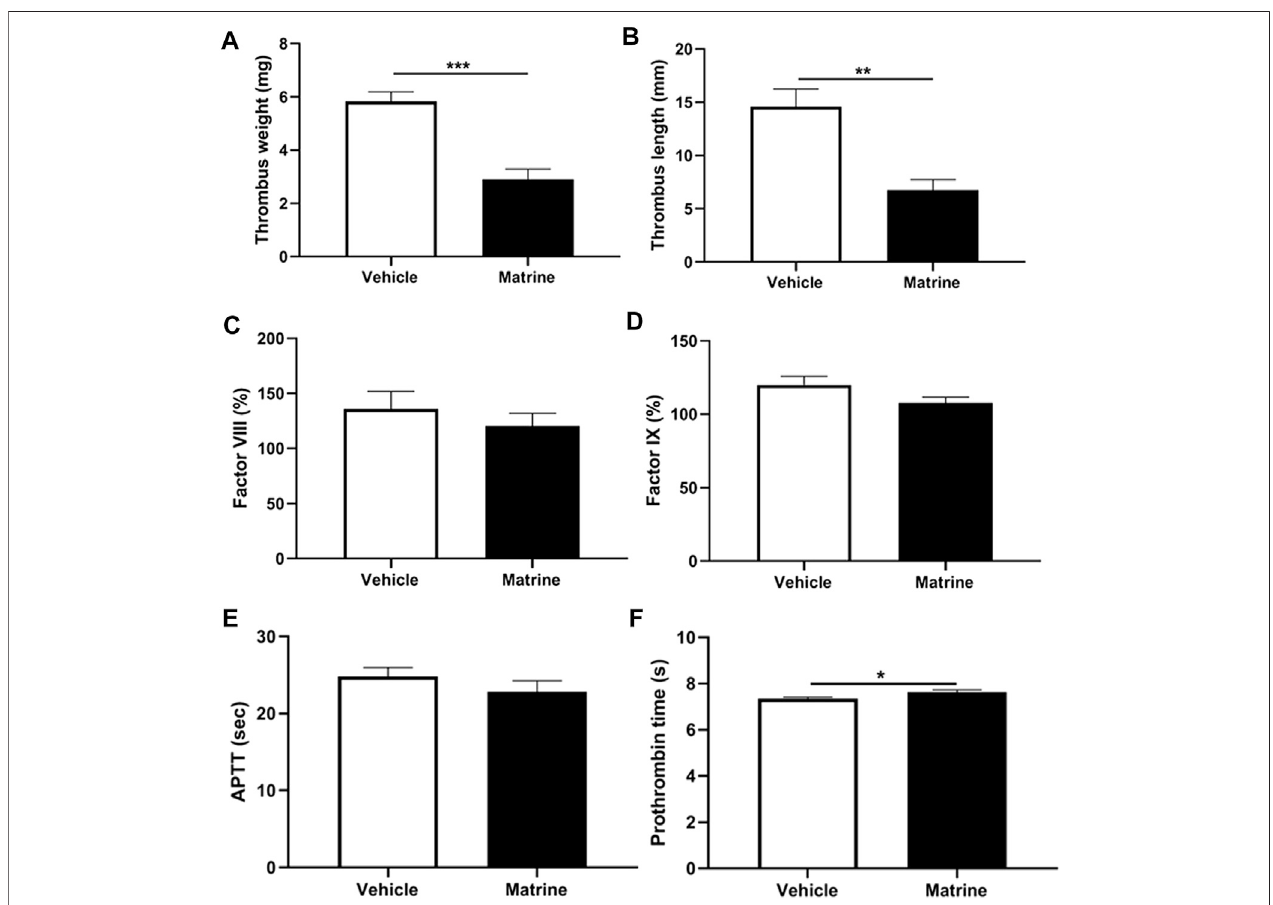
FIGURE 5 | Deep vein thrombus formation and coagulation analysis. After intraperitoneal injection of matrine (10 mg/kg) or vehicle, mice underwent ligation of inferior vena cava (IVC) to induce venous thrombus formation. After 24 h, the IVC samples were isolated to measure thrombus weight (A) and length (B) . Meanwhile, peripheralbloodwasobtainedfrommatrineorvehicletreatedmicetodetectthecoagulationfactorFVIII (C) ,FIX (D) ,activated partialthromboplastintime(APTT) (E) and prothrombin time (F) . Data were presented as mean ± SE ( n (cid:2) 4 – 6). ** p < 0.01; *** p <